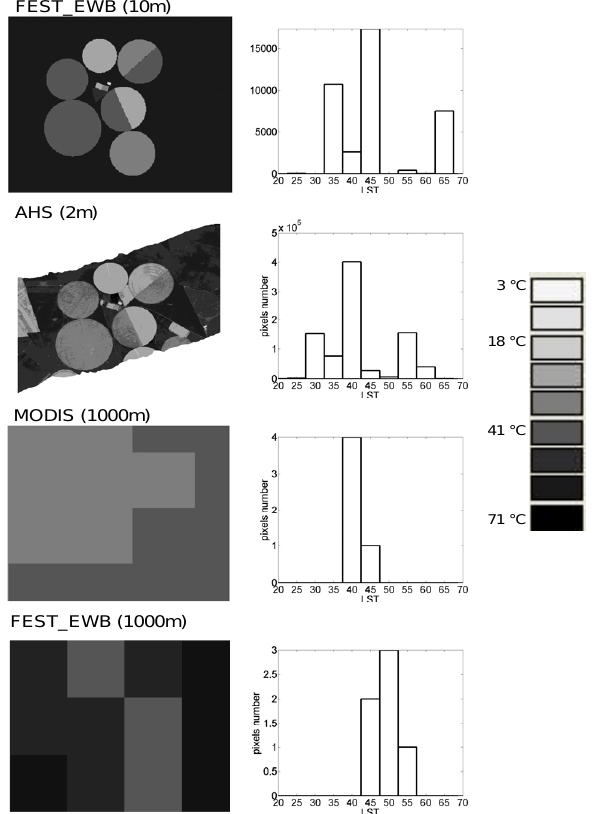
Fig. 5. Frequency distribution for LST from AHS, FEST-EWB (10m–1000m) and MODIS for 13 July at 00:10.